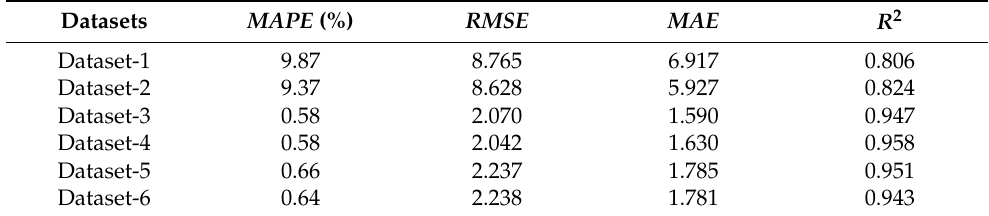
Figure 8. Dataset − 1~6 prediction results. Table 2. GWO-VMD-LSTM prediction error of six